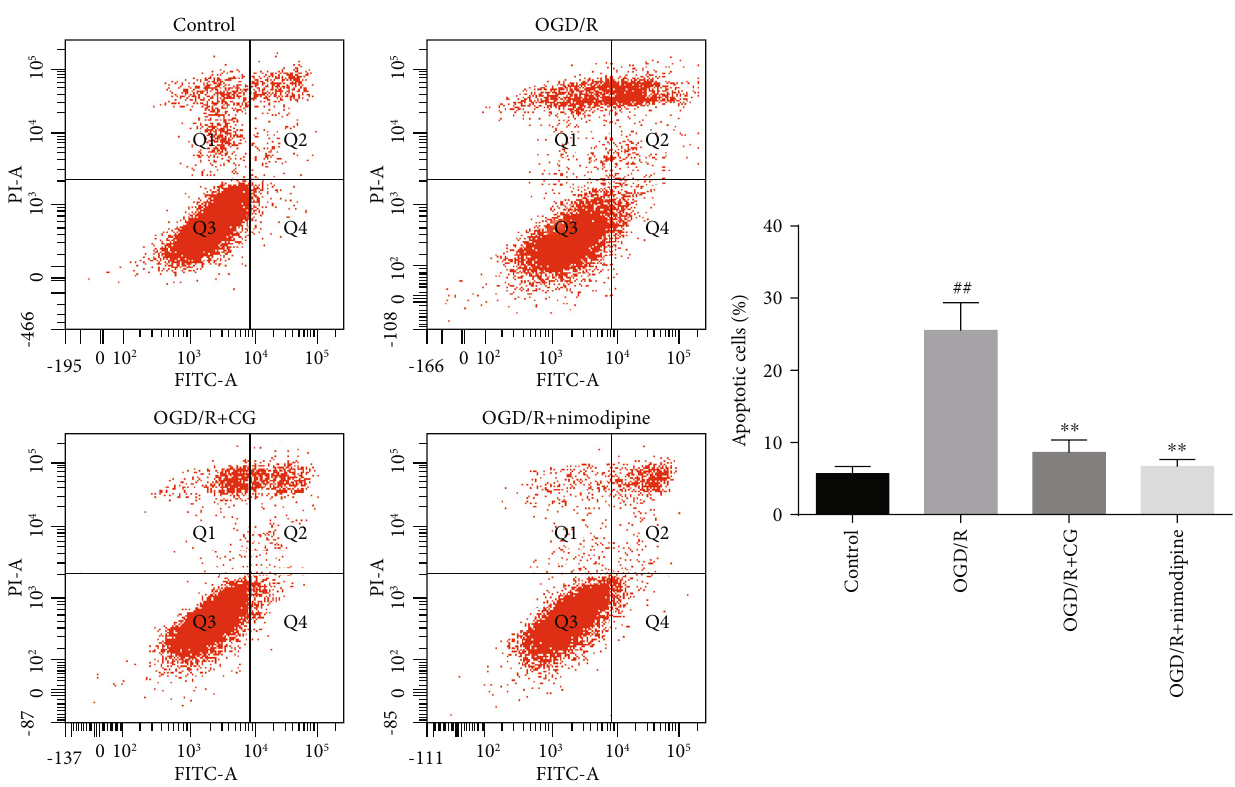
Figure 4: Apoptosis rate of HT22 cells after treatment with 8 h of OGD and reoxygenated in the presence of CG for 6h. Three independent experiments were performed, and data were expressed as the mean ± SD . ## P < 0 : 01 vs. control group, ∗∗ P < 0 : 01 vs. OGD/R